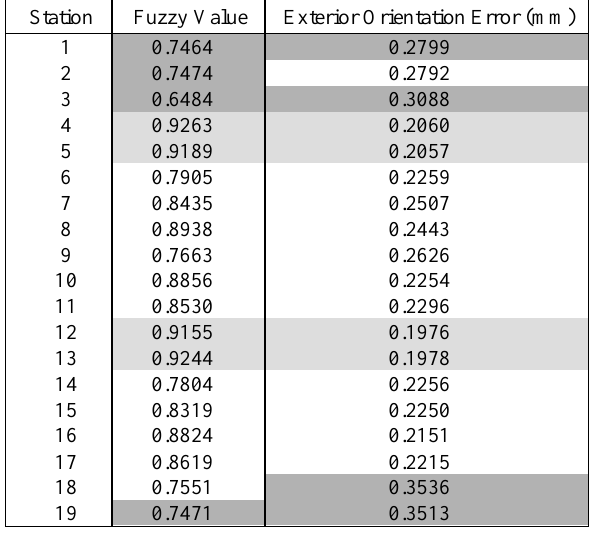
Table 2. Exterior orientation errors and the result of fuzzy value of each station in measuring the propeller In Table 2, four maximum exterior orientation standard deviation values and four minimum fuzzy values are highlighted with the color of chromatic gray and also four minimum exterior orientation standard deviation values and four maximum fuzzy values are highlighted with the color of pallid gray. As Table 2 shows, the results for stations that have maximum/minimum exterior orientation standard deviation values are almost the same as the stations that have minimum/maximum fuzzy values. After omission of stations with low fuzzy values, bundle adjustment procedure was done with the rest of images. The result of bundle adjustment before and after omission of inappropriate images is shown in Table 3.